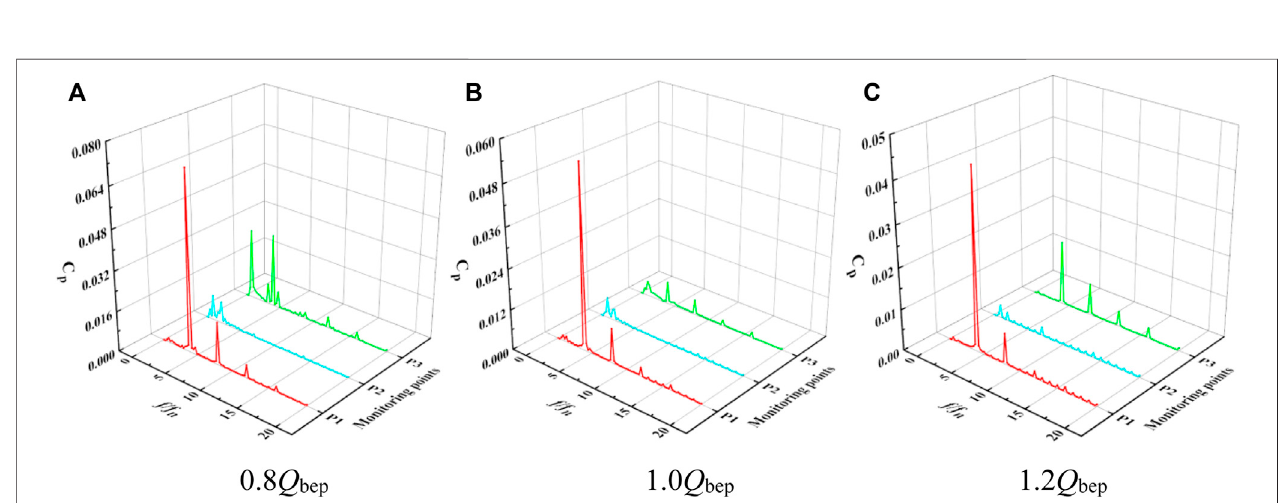
FIGURE 12 | Time domain diagram of pressure pulsation at each monitoring point of the impeller.